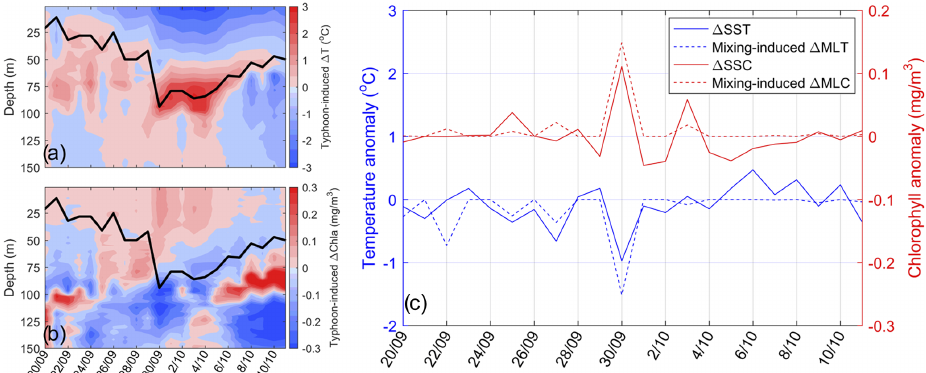
Figure 4. Sections of typhoon-induced changes in (a) temperature and (b) chlorophyll concentration. The changes were calculated for each day’s section by subtracting the averaged section from 7d prior to 20 September (i.e., 13 to 19 September). (c) Time series of the change in sea surface temperature ( (cid:49) SST, solid blue), mixing-induced change in the MLT (dashed blue), sea surface chlorophyll concentration ( (cid:49) SSC, solid red) and mixing-induced change in the MLC (dashed